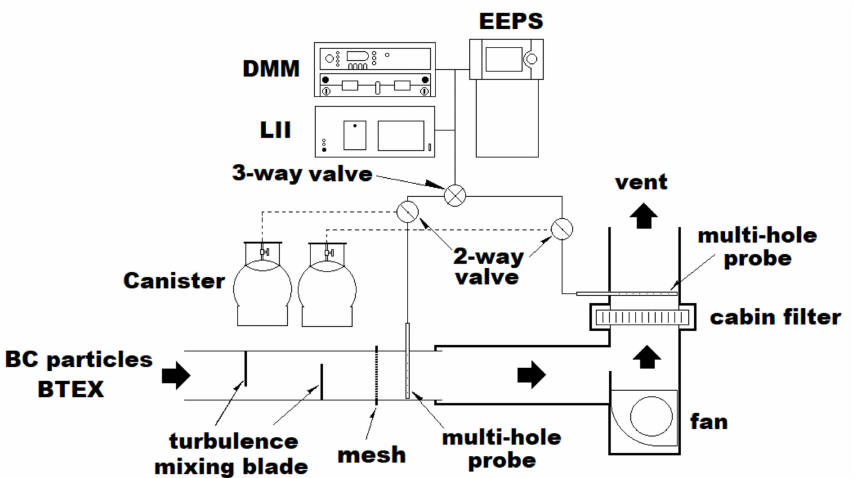
Figure 1. Schematic diagram of the experiment